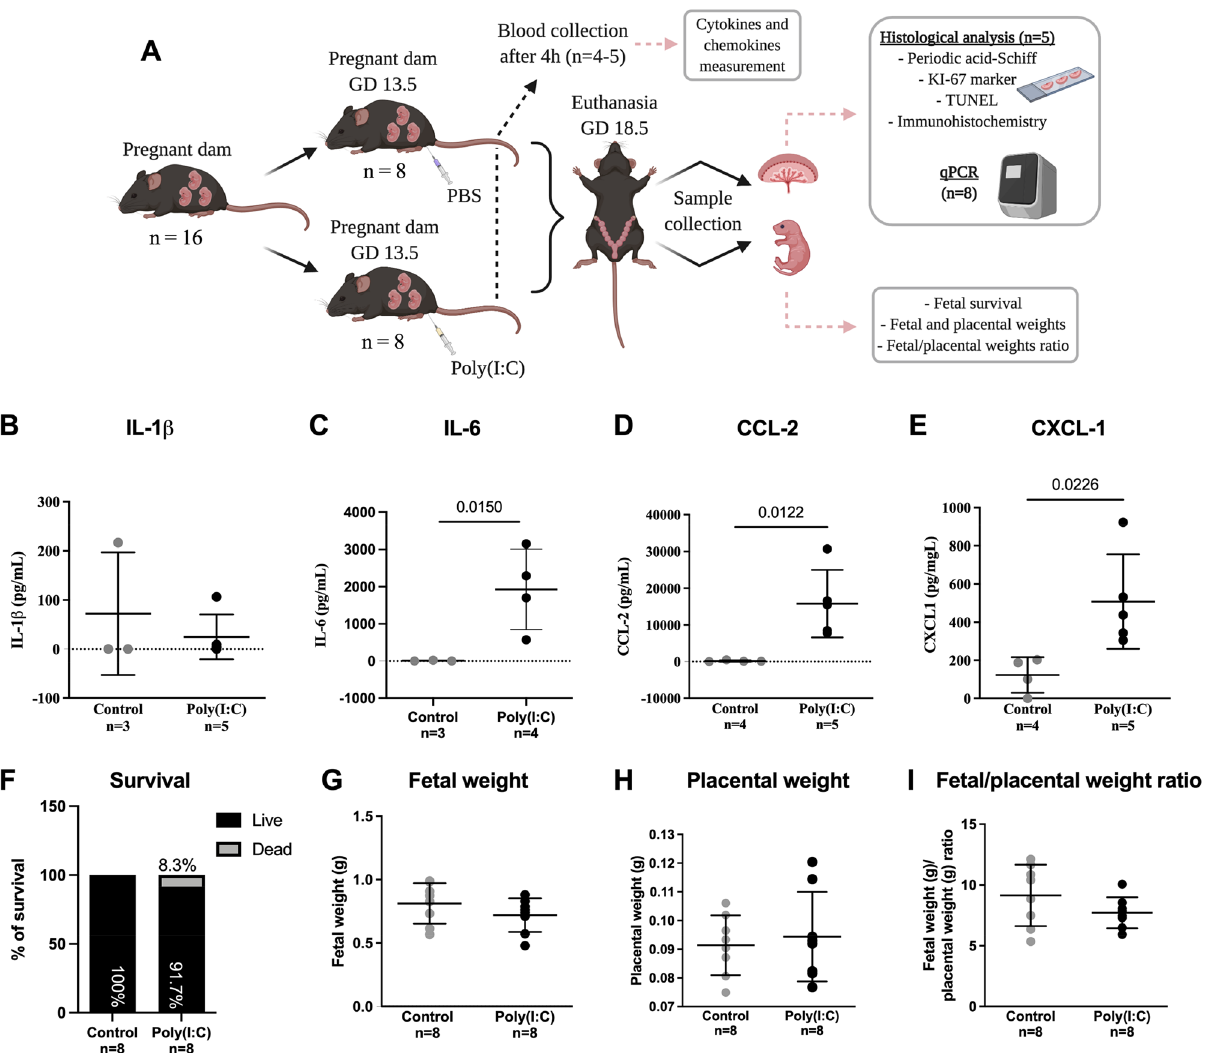
Figure 1. Mid-pregnancy poly(I:C) induces an acute maternal systemic inflammation and affects fetal and placental weight at term. ( A ) Experimental design (created with BioRender.com). ( B–E ) Maternal IL-1β ( B ), IL-6 ( C ), CCL-2 ( D ) and CXCL-1 ( E ) levels in maternal plasma. ( F ) Percentage of fetus survival. The N number in each group corresponds to the number of litters. ( G – I ) Fetal ( G ) and placental ( H ) weights, and fetal/placental ratio ( I ). The values of fetal and placental weights and their ratio correspond to the litter mean. The graphs were plotted in aligned dot plot, the gray circles represent the control group, and the black circles represent the poly(I:C) group. One outlier from control group (IL-1β), one outlier from control and poly(I:C) groups (IL-6) were removed according to Grubb’s test. Values are expressed as mean ± SD. Mann–Whitney test was performed for fetal/placental weight ratio and IL-1β. Student’s t test was used for the remaining